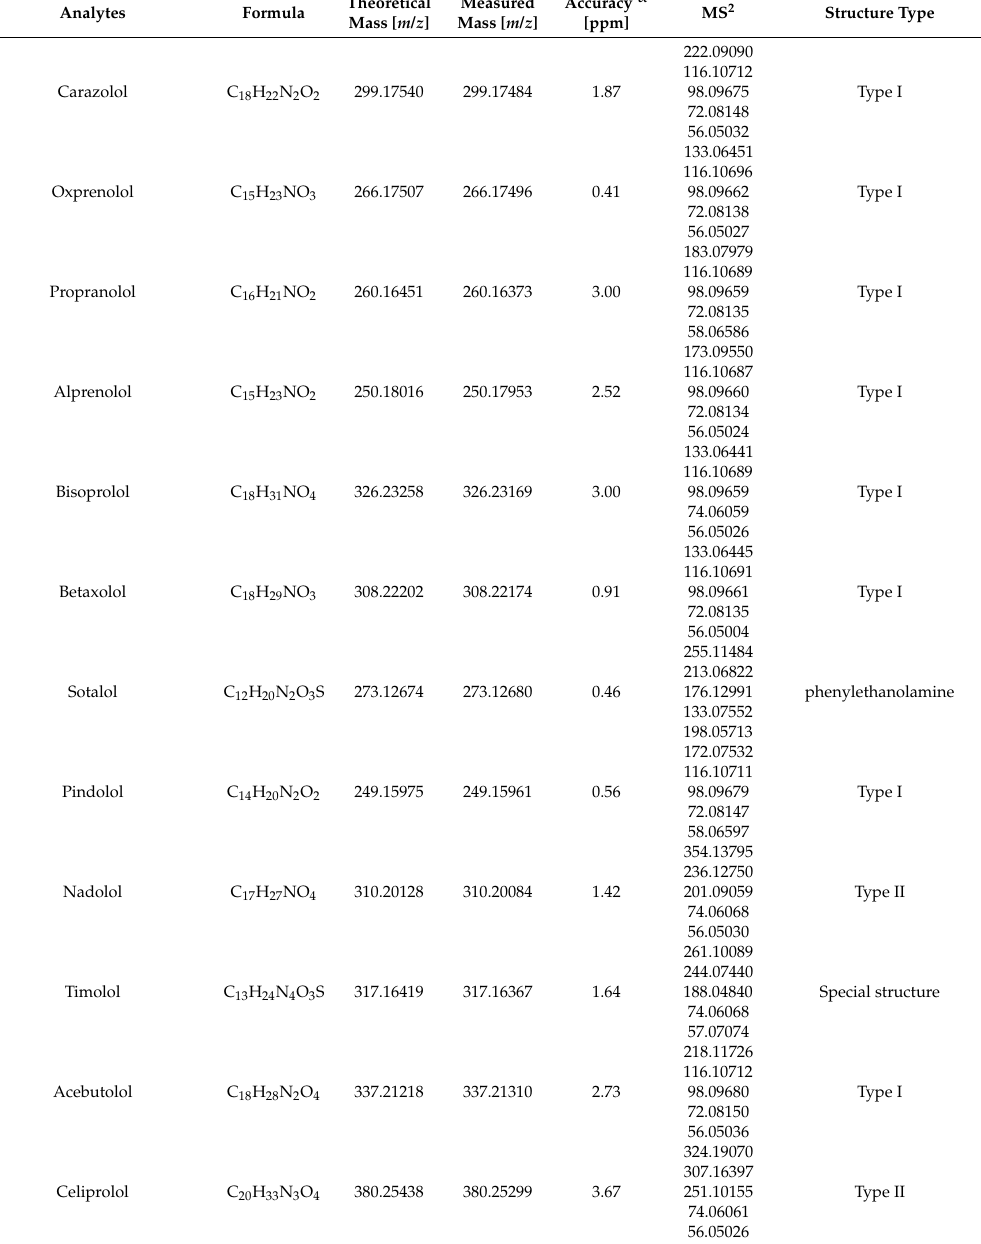
Table 1. Formula, ionization mode, theoretical mass, measured mass, mass accuracy and MS 2 data for 27 β -blockers.